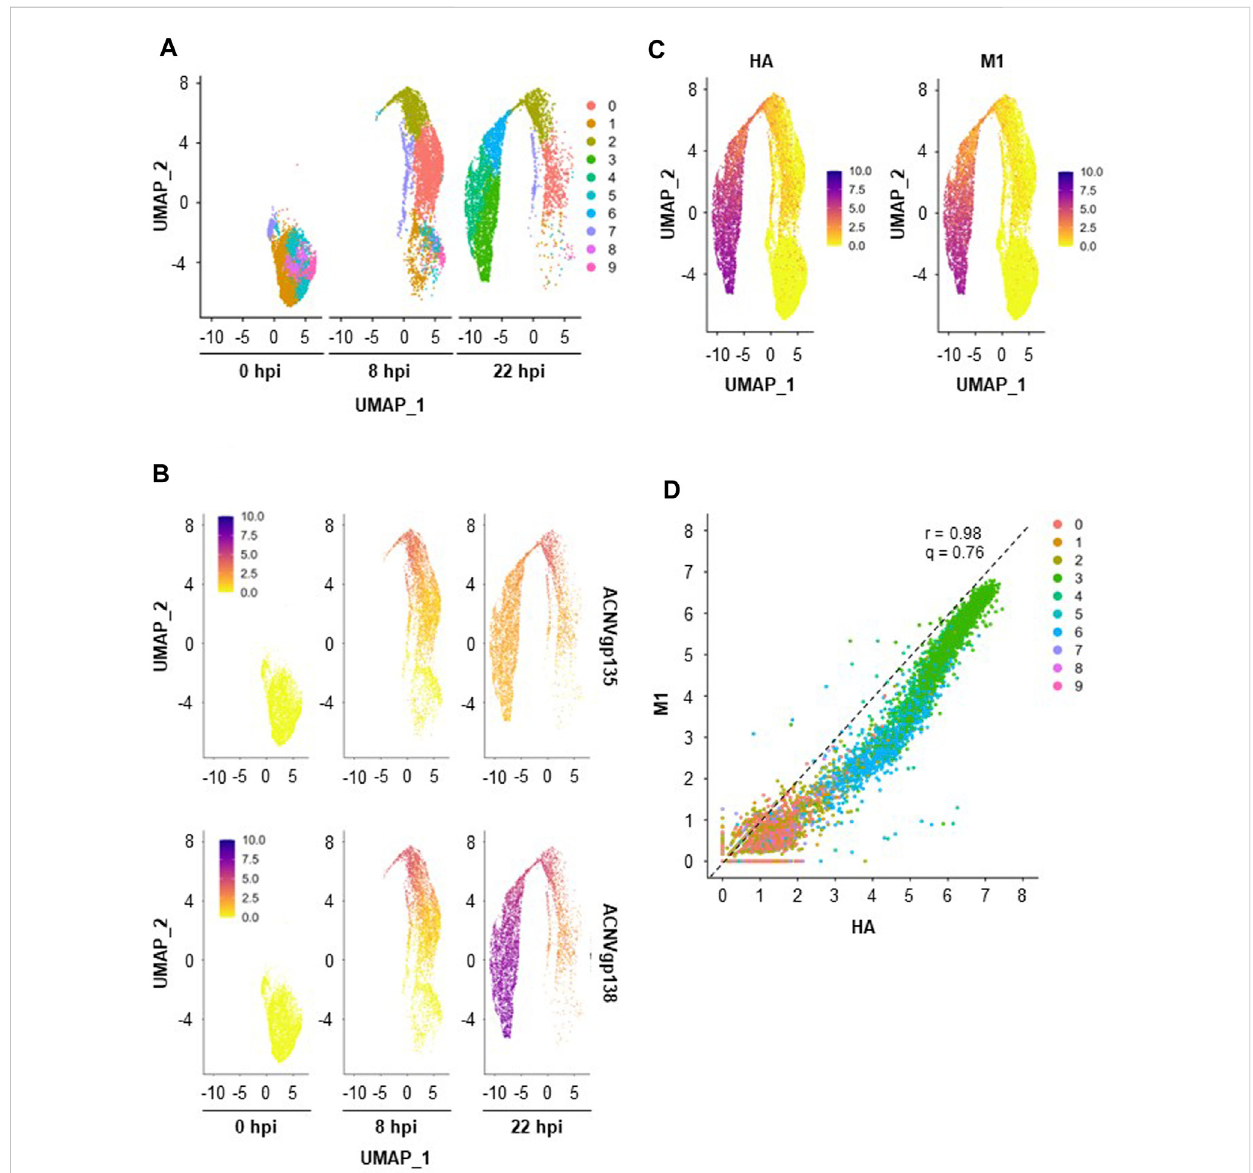
FIGURE 3 Insect cells clustering and transgenesexpression. (A) Merged scRNA-seq dataset obtained with UMAP. (B) Relative expression of early ( ACNVgp135 ) and late ( ACNVgp138 ) baculovirus genes. (C) Relative expression of transgenes HA and M1. A color gradient scale was used to show the relative gene expression per cell. (D) Relative HA and M expression per cell, with dashed line representing the best linear fi t to the data (r — Pearson ’ s correlation coef fi cient, q – angular coef fi cient). A color code was used to identify each cell